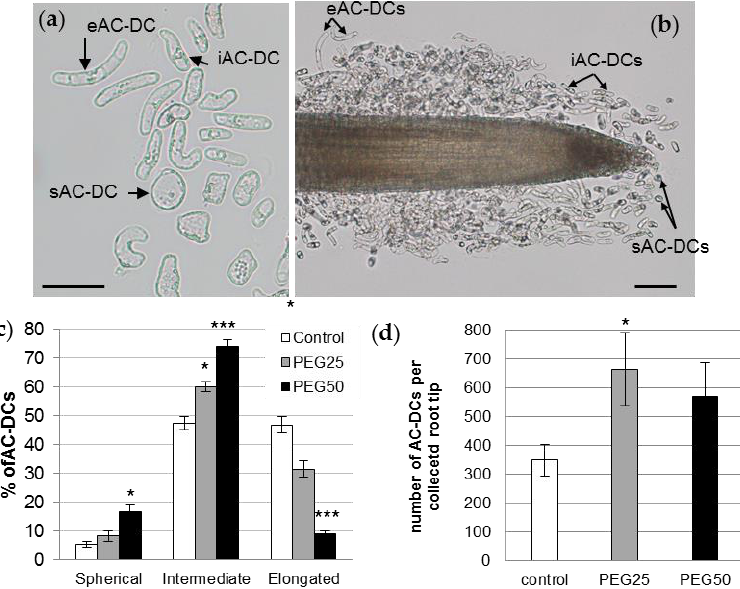
Figure 4. P. nigra root AC-DCs. ( a ) A microscopy image of AC-DCs collected on day 6 from a control root tip. Three different morphotypes were observed in the RET and characterized by their length to width ratio (R): sAC-DC, «spherical» (1 ≤ R < 2); iAC-DC, «intermediate» (2 ≤ R < 5.5); and eAC- DC, «elongated» (R ≥ 5.5); bar scale: 50 μm. ( b ) Location of the different AC-DC morphotypes along the root tip of a 6-day- old control plant; bar scale: 100 μm. ( c ) Relative proportions of different morphotypes of root AC-DCs collected from root tips after 72 h under control and osmotic stress conditions. ( d ) Total number of AC-DCs collected per root tip. Mean and standard error of 9 roots from 3 biological replicates. *: significant at level alpha = 0.05; ***: significant at level alpha = 0.0001 according to a Kruskal–Wallis test with Dunn’s procedure.